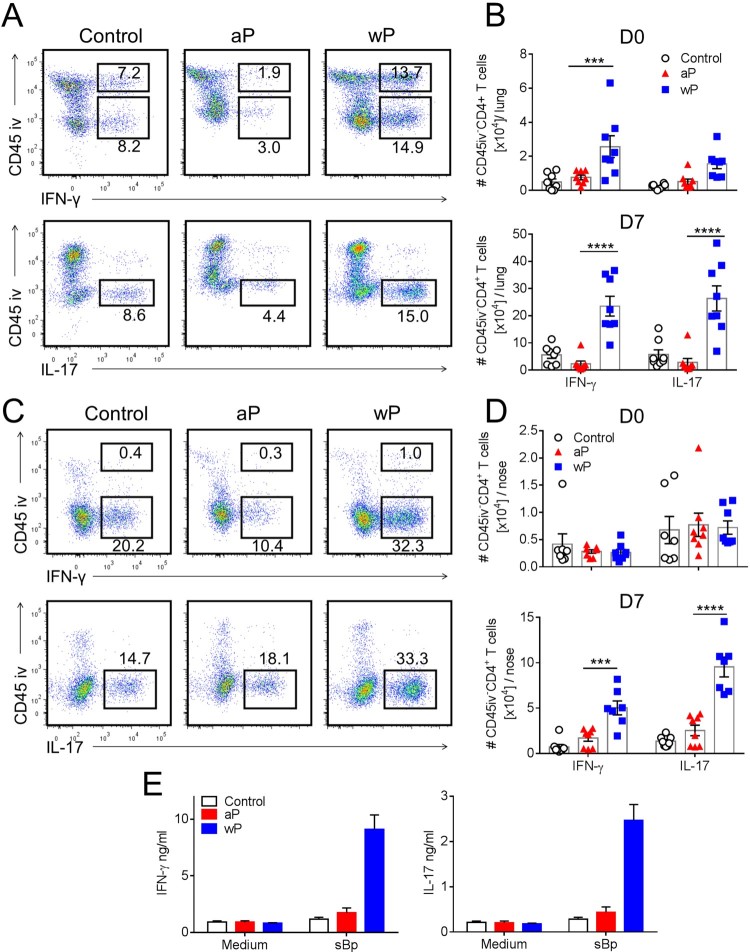
CD4 T cells in the lung and nasal tissue of mice immunized with a wP vaccine and challenged with B. pertussis potently secreted IFN-γ and IL-17. C57BL/6 mice were immunized and challenged, and tissue-resident cells were quantified as described in Figure 1. Intracellular cytokine staining and flow cytometry were performed on lung and nasal tissue T cells one day before (D0) and 7 days post challenge (D7). Representative plots showing IFN-γ and IL-17 secretion by lung (a) and nasal tissue (c) CD4 T cells. Total number of IFN-γ- and IL-17-secreting lung and nasal CD45iv–CD4 T cells in the lungs (b) and nasal tissue (d). Results shown are mean ± SEM (n = 8 in two independent experiments). ***p < .001, ****p < .0001 versus aP by two-way ANOVA with the Tukey’s post-test, only significant differences between experimental groups are indicated. (e) Tissue-resident CD45iv–CD4+ T cells purified from the lungs 2 weeks post immunization (prior to B. pertussis challenge) were stimulated with sonicated B. pertussis (sBp) in the presence of irradiated splenic APC. After 3 days of culture, IFN-γ and IL-17 was quantified in supernatants by ELISA. Results shown are mean ± SD for triplicate culture of cells pooled from 4 mice per group.